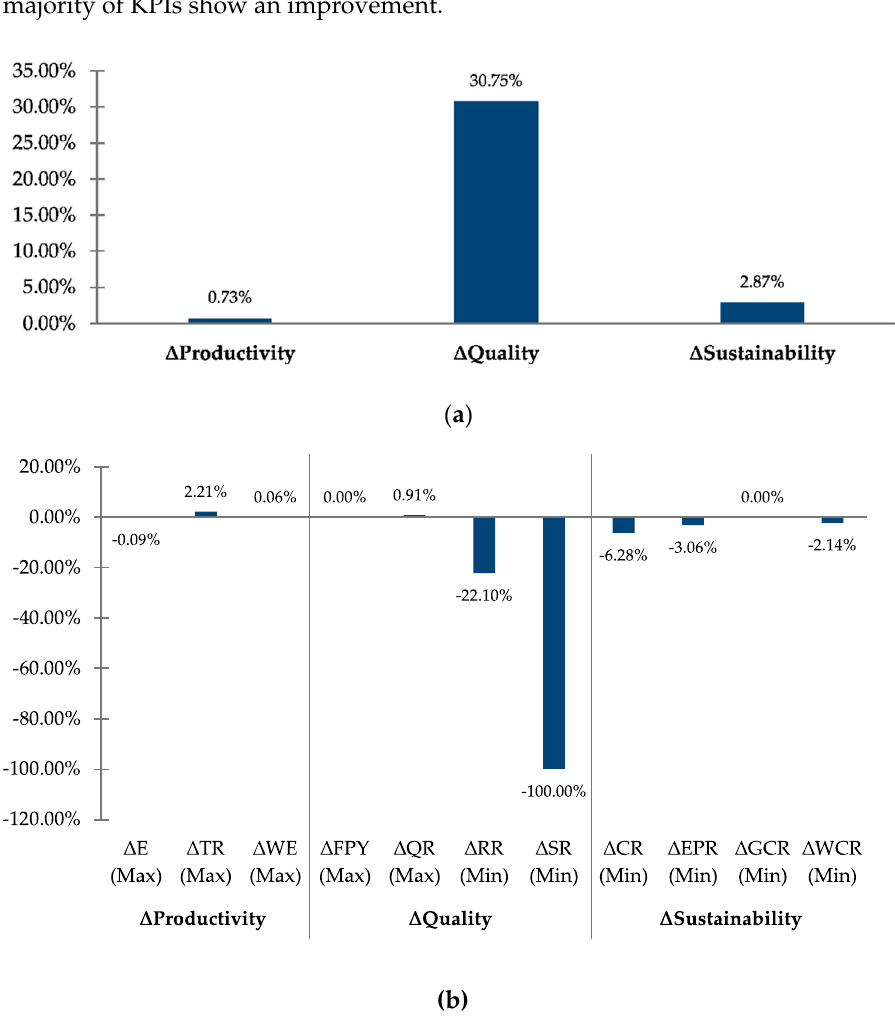
Figure 11. Influence of 5G technology and motion control use case compared to Ethernet and no motion control use case on technical goals. ( a ) all goals with a positive delta; ( b ) the delta of the corresponding KPIs as well as their optimization trend.